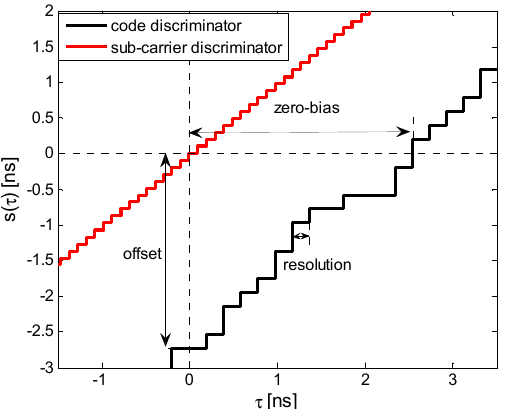
Figure 2. Schematic diagram of resolution error and zero-bias of the digital discriminator of the BOCs (1, 1) signal.